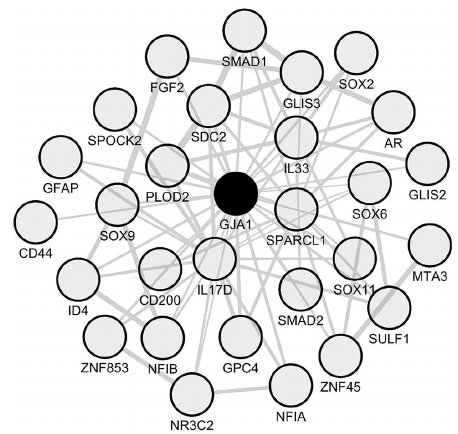
Figure 5. Astrocyte signature inferred from the GJA1 / Cx43 co-expression module in spinal cord periplaques. To identify an astrocyte molecular signature in spinal cord periplaques, we used the astrocyte-specific hub gene Cx43 / GJA1 as a “bait” and retrieved the top-200 mRNA species that most closely co-upregulated with Cx43 / GJA1 . The co-expression network formed by functionally-relevant genes is shown. Genes are designated by their gene symbols. Gene full names are provided in Table 2.